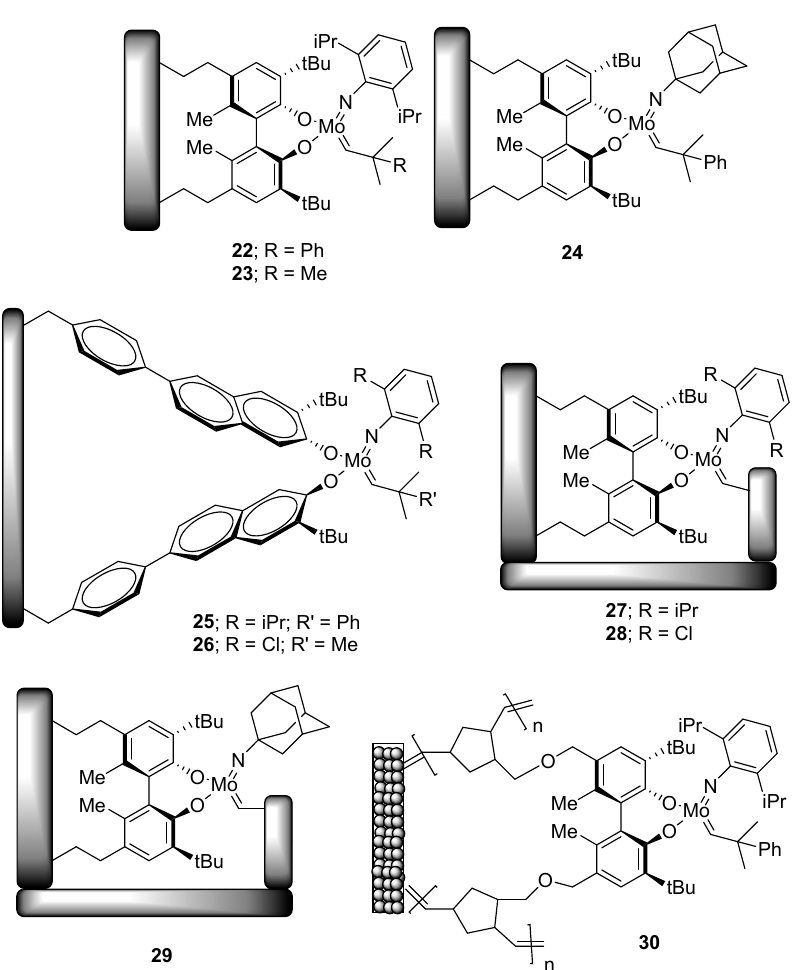
Figure 5. Polystyrene-based-supported Schrock catalysts 22 – 26 and polynorbornene-based-supported Schrock catalysts 27 – 30 .